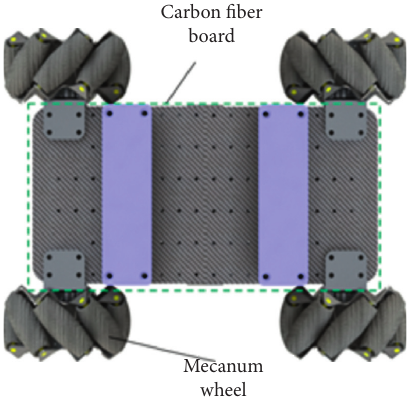
Figure 2: GIS equipment inspection robot chassis structure